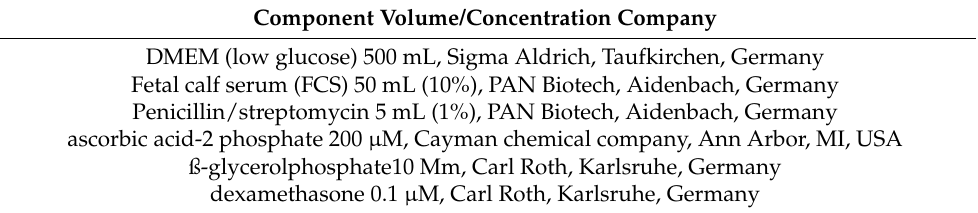
Table 2. Osteogenic differentiation medium.